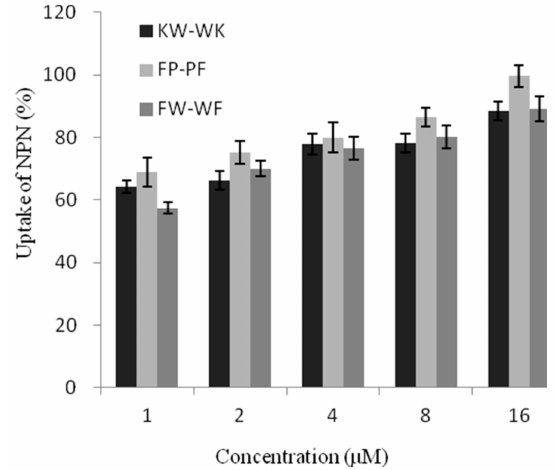
Figure 5. Uptake of NPN in E. coli UB1005 cells treated with different concentrations of antimicrobial peptides.